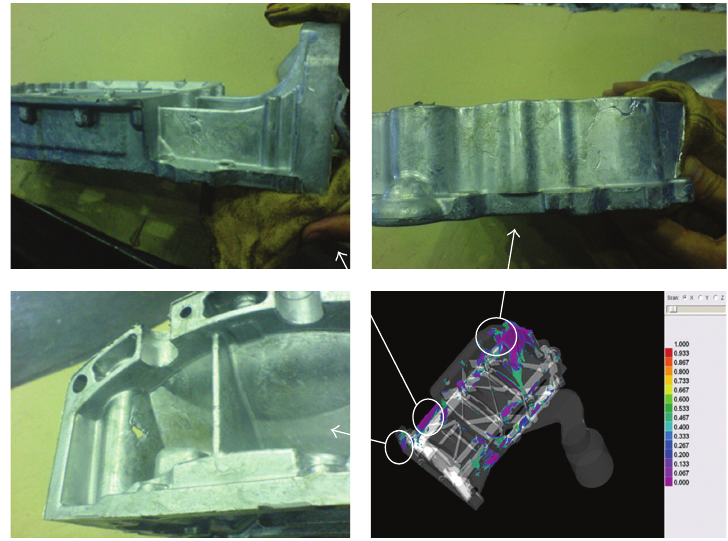
Figure 5: Cold flow surface defects at final filling positions.